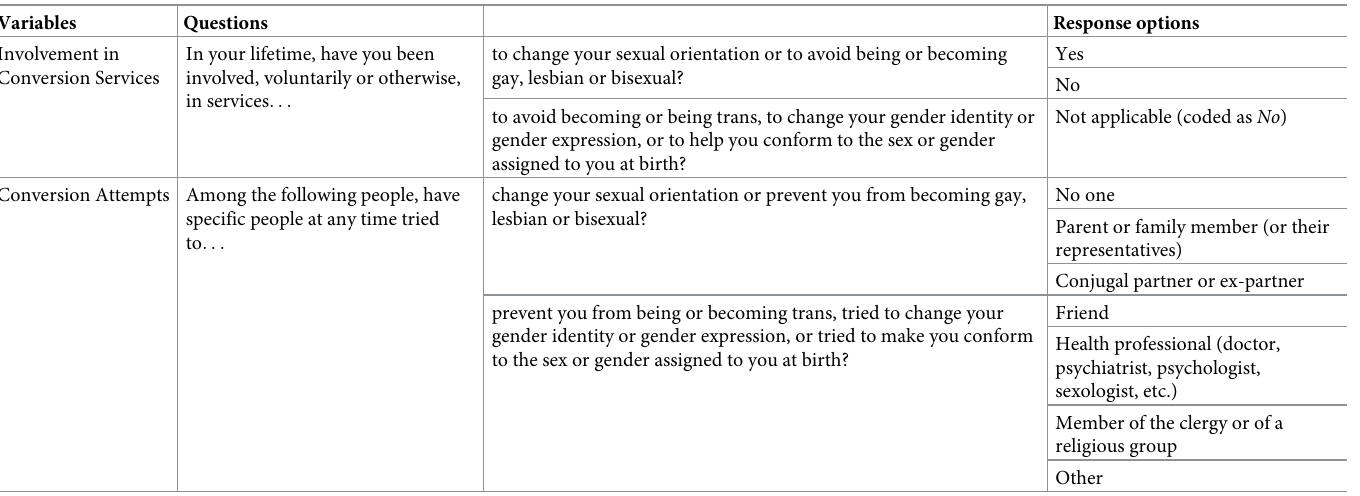
Table 1. Items measuring SOGIE conversion attempts and involvement in conversion